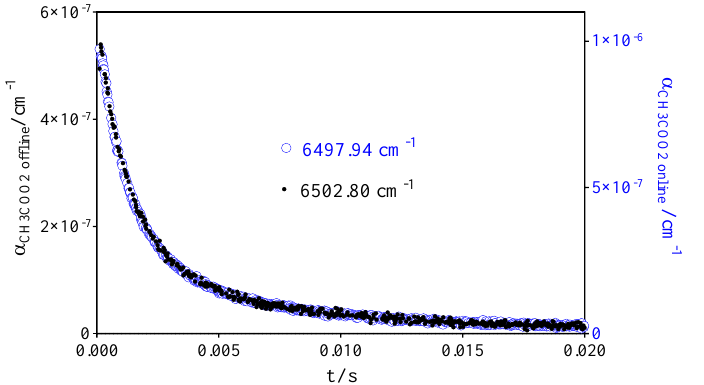
Figure 1. Kinetic decays at two different wavelengths, obtained following the 248 nm photolysis of [CH 3 C(O)CH 3 ] = 8.5 × 10 15 cm −3 . Each data point results from one ring-down event, no averaging has been performed.